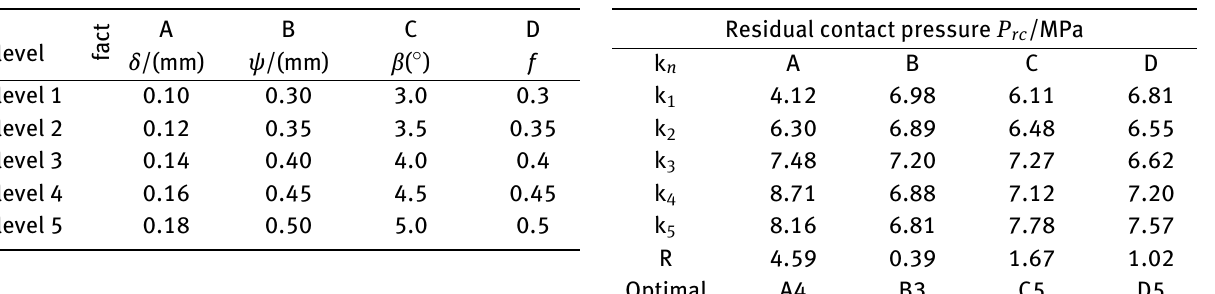
Table 3: Residual contact pressure of orthogonal